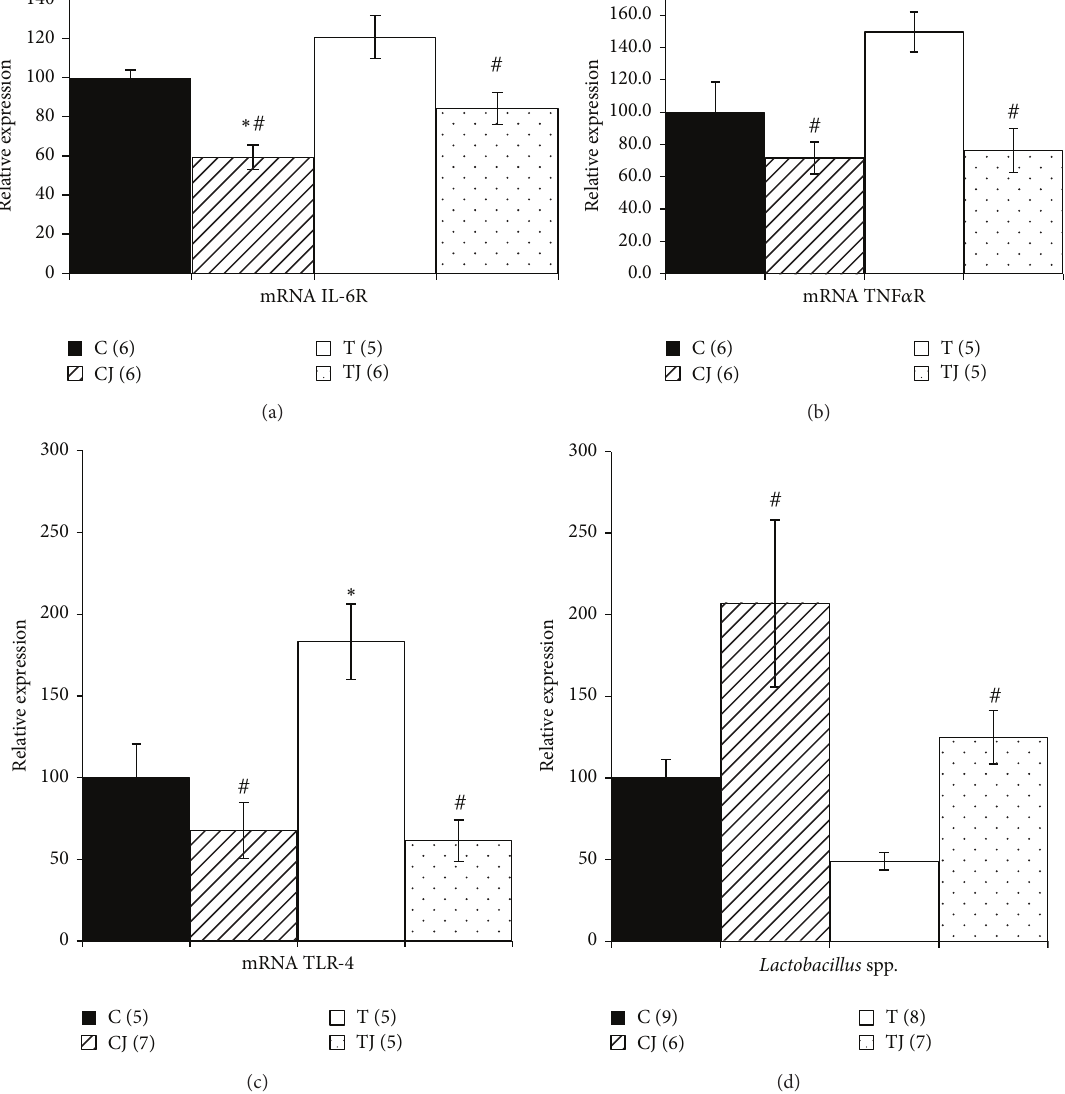
Figure 2: Gene expression of IL-6 receptor (IL-6R) (a), tumor necrosis factor- 𝛼 receptor (TNF- 𝛼 R) (b), Toll-like receptor 4 (TLR4) (c), and DNA levels of Lactobacillus spp. in 21-day-old offspring colon (d). C: offspring of dams fed control diet; CJ: offspring of dams fed